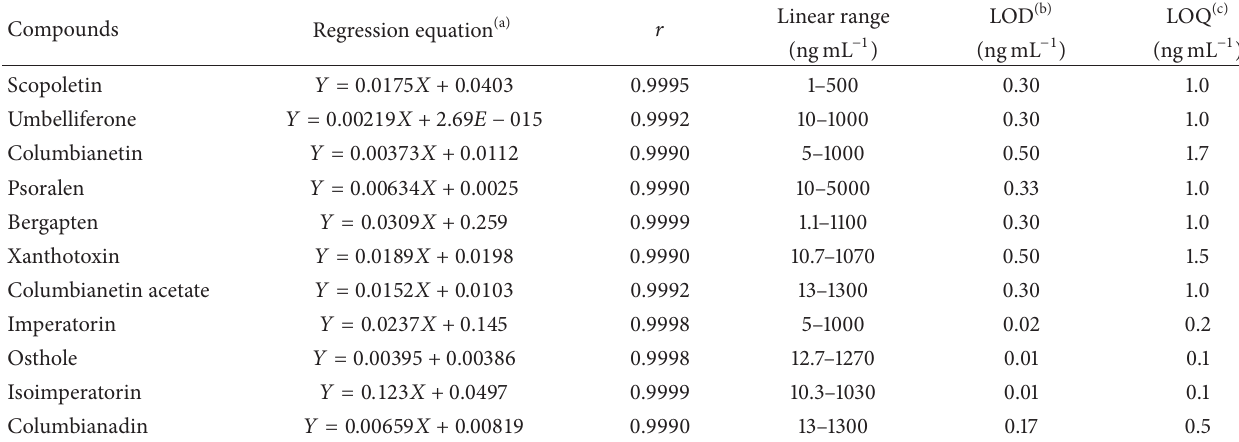
Table 2: The calibration curves, LODs and LOQs ( 𝑛 = 5 ) for the active components of the assay.